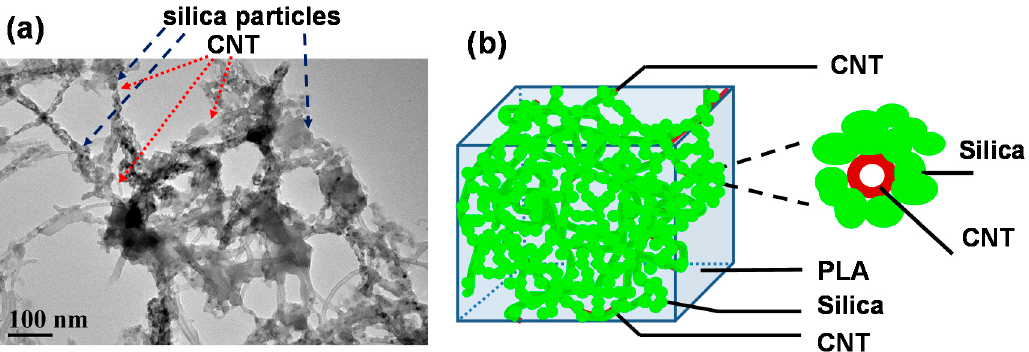
Figure 8. TEM microphotograph of PLA/MWCNT-silica nanocomposites: ( a ) nanocomposite with a MWCNT-silica content of 0.5 wt % and ( b ) schematic depiction of the MWCNT-grafted silica in the PLA matrix.